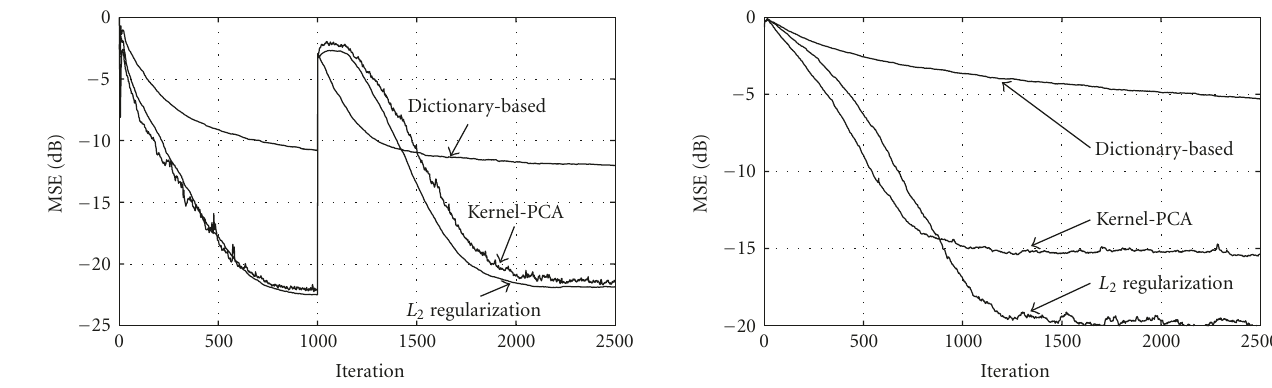
Figure 12: MSE e 2 [ n ] on the Hammerstein system’s internal signal r r [ n ] for the three adaptive kernel CCA-based